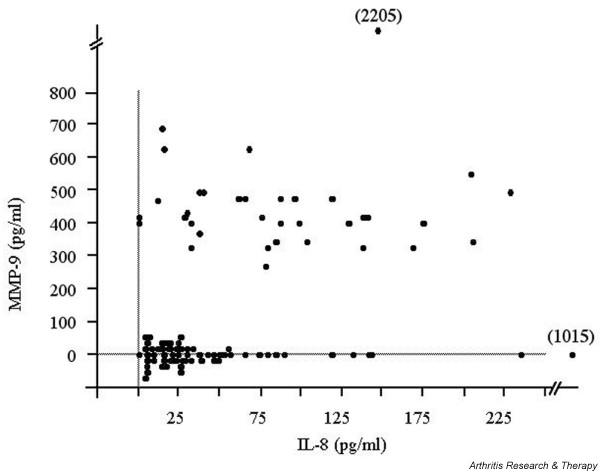
Scattergram showing relationship between IL-8 and matrix metalloproteinase (MMP)-9 in cerebrospinal fluid of all patients with systemic lupus erythematosus (r = 0.47; P < 0.0001).